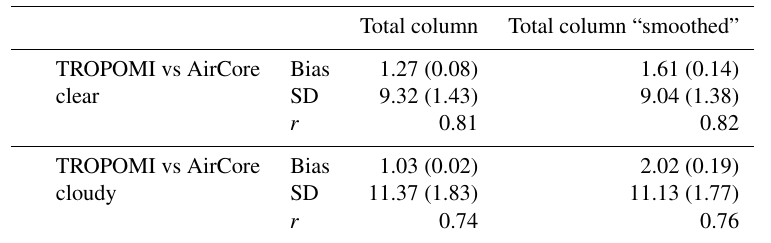
Table 3. Summary of statistics from the comparison of total CO column values from TROPOMI (under either clear or cloudy conditions) and AirCore. Bias and SD values are provided in percent (%) and in units of 10 17 molec.cm − 2 (in parentheses).